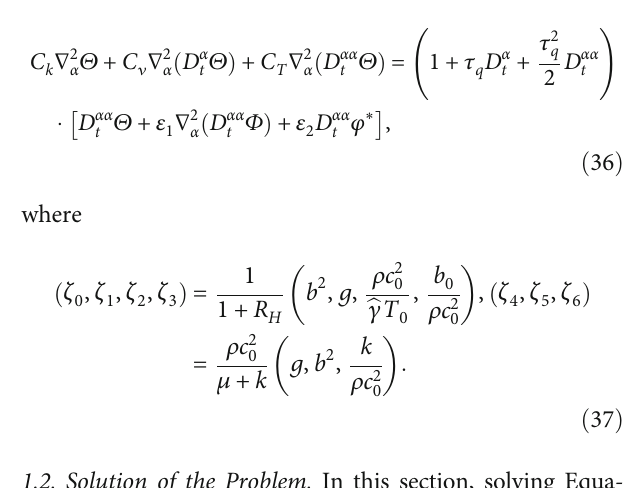
Figure 1: The various values of the amplitudes j z angle of incidence θ for various values of the fractional parameter of the diverse values of gravity g